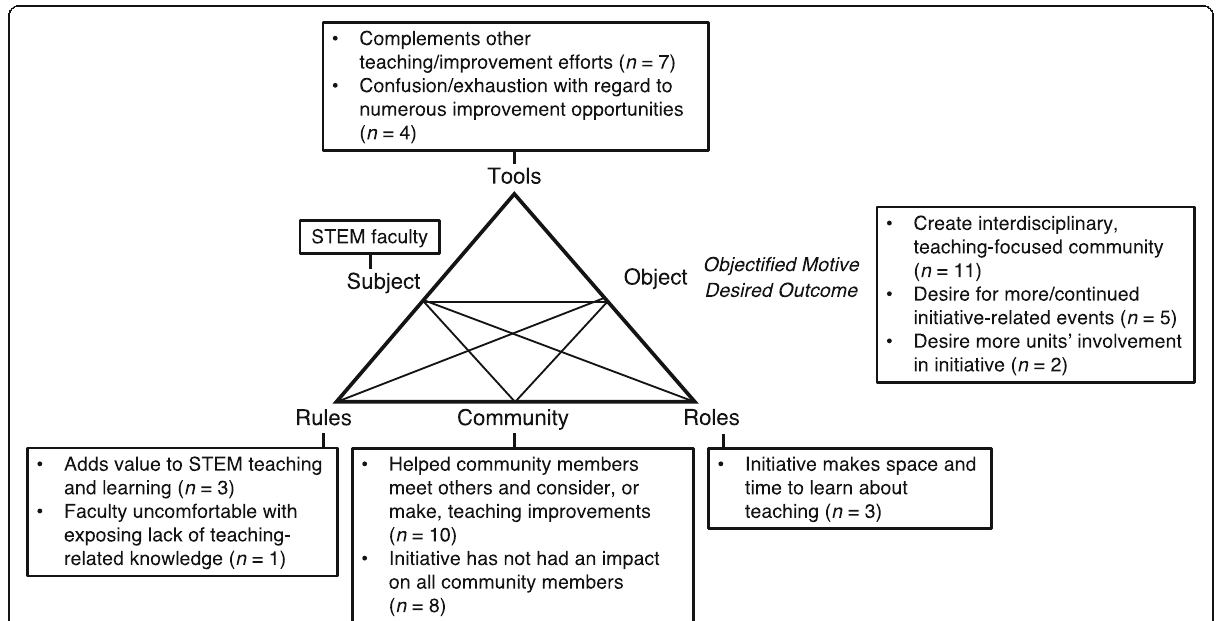
Fig. 3 Ways an instructional improvement initiative influenced STEM faculty engagement in the activity of talking about teaching-related topics. The number of participants who contributed interview excerpts for each code is given by